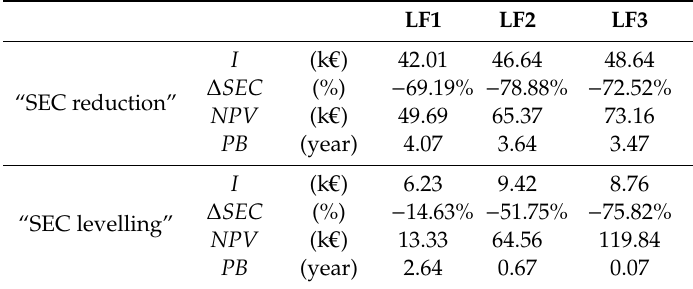
Table 1. Expected results of the numerical example for di ff erent load factors in scenario 2 if the demand rate follows a normal distribution.